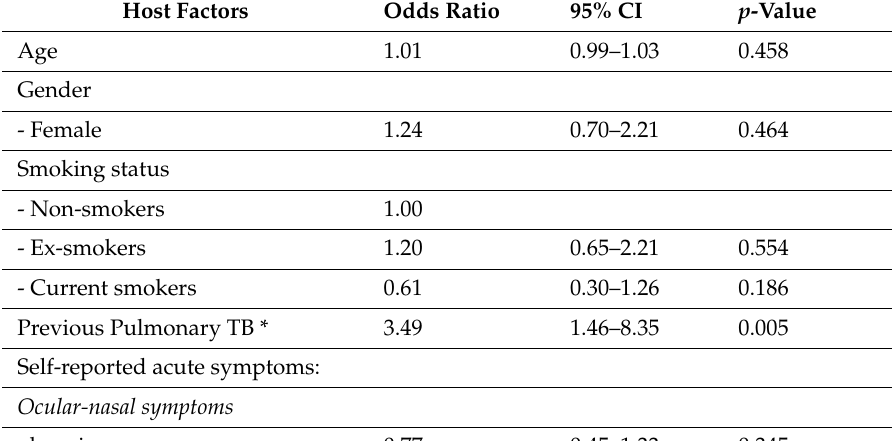
Table 4. Relationship between host factor attributes associated with persistent lower respiratory symptoms/asthma in subjects exposed to the sulphur stockpile fire